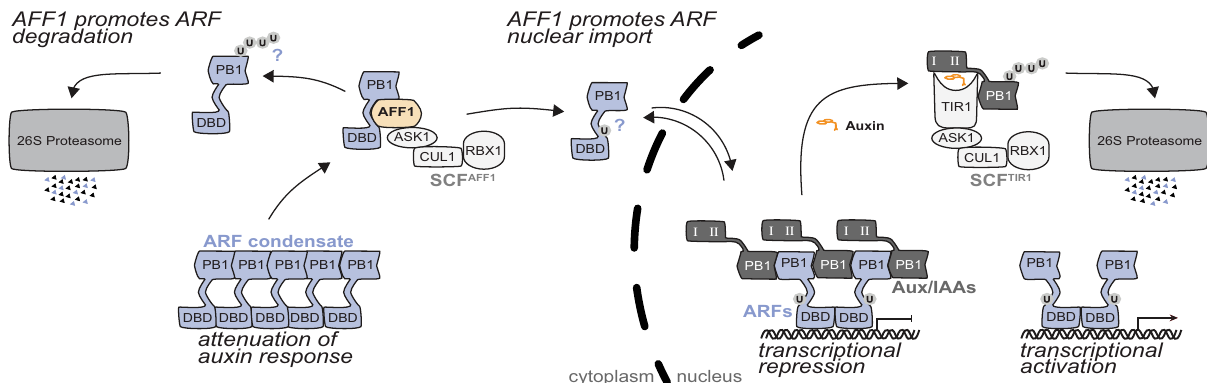
Fig. 7 A proposed model for the SCF AFF1 role in regulating ARF condensation and nucleo-cytoplasmic partitioning. SCF AFF1 directly interacts with ARF19 and ARF7, suggesting that these transcription factors, and perhaps additional ARFs, are substrates of this putative E3 ubiquitin ligase. Further, the distinct aff1 mutant effects on ARF protein accumulation/condensation and localization, along with the identity of AFF1 as an E3 ubiquitin ligase, raises the possibility that distinct ubiquitin moieties promote these distinct fates of the ARF transcription factors, both of which may be mediated by SCF AFF1 experiments. For phenotypic assays, seeds were surface sterilized for 15 min with 20% (v/v) bleach and 0.01% (v/v) Triton X-100, then rinsed four times with sterile water. Sterilized seeds were suspended in 0.1% (w/v) agar and then strati fi ed for 2 d at 4°C to promote uniform germination. After strati fi cation, seeds were plated on plant nutrient (PN) media solidi fi ed with 0.6% (w/v) agar and supplemented with 0.5% (w/v) sucrose (PNS) at 22°C under continuous illumination. To analyze the leaf phenotypes of Wt and mutants, seeds were directly germinated in the soil. Images were taken after 22 d of growth at 22 °C under continuous illumination. To examine root elongation in Wt and mutants, root lengths were measured from seedlings grown on media supplemented with mock